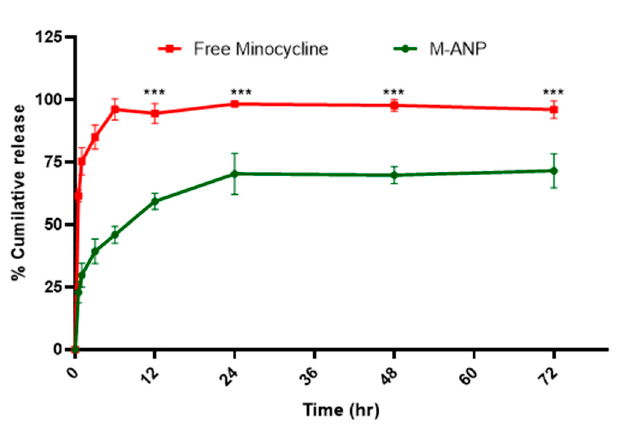
Figure 5. Drug release profile of minocycline loaded Albumin Nanoparticle. Values shown here represent SD ( n = 3). Two-way Anova, Multiple comparison analysis *** p < 0.001 .